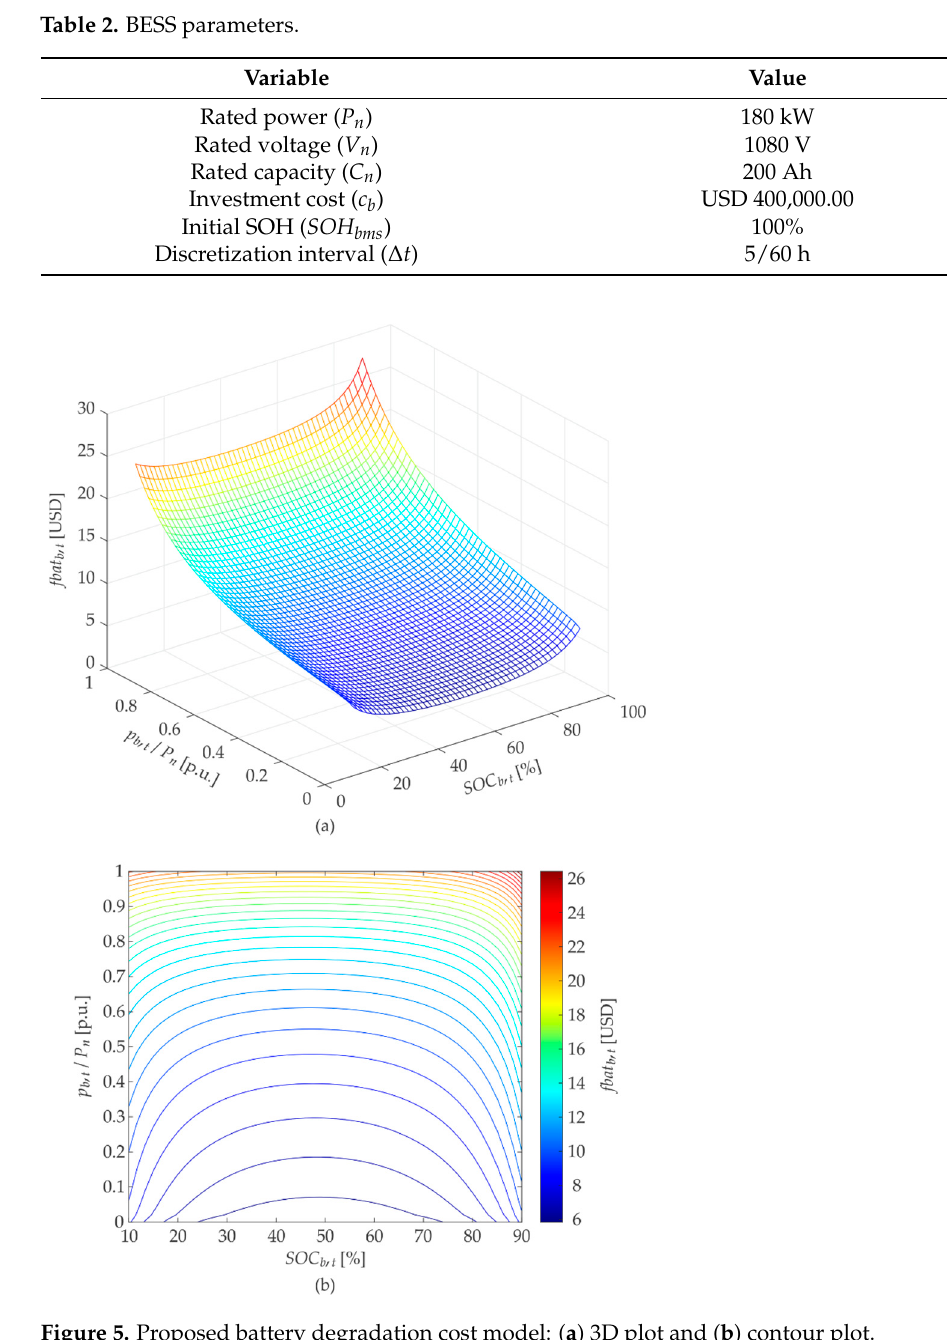
Figure 5. Proposed battery degradation cost model: ( a ) 3D plot and ( b ) contour